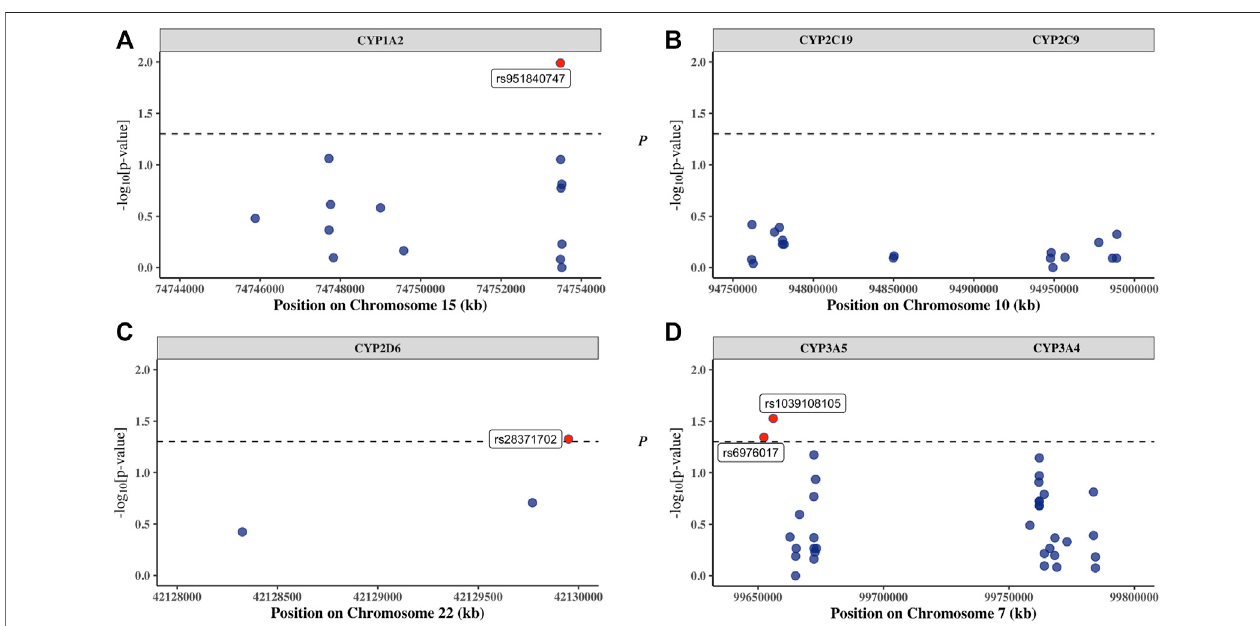
FIGURE 1 | The position of each single nucleotide polymorphism (SNP) on their respective chromosome versus − log10 ( p -value) is displayed for (A) CYP1A2 , (B) CYP2C9/19 , (C) CYP2D6 ,and (D) CYP3A4/5 .Thethreshold forsigni fi cancewassetat p =0.05(black dottedline),withSNPssigni fi cantlyassociatedwithPZQef fi cacy (red dots) labelled with their SNP identi fi